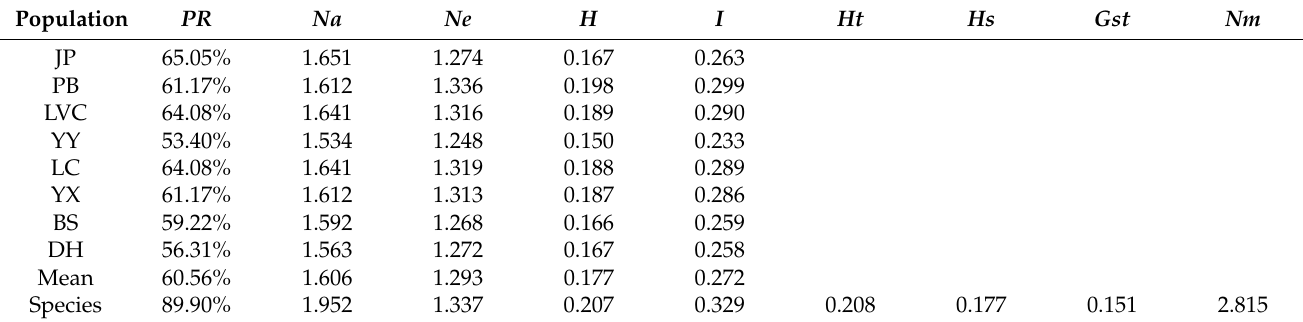
Table 4. Genetic diversity of A. tsao-ko populations by PAAP